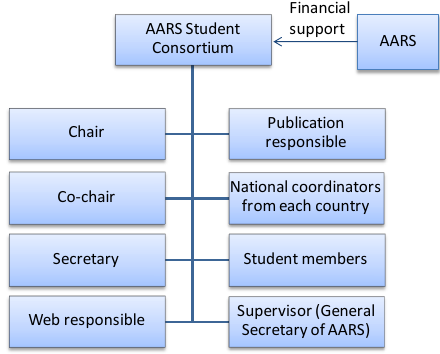
Figure 5. Proposed structure of the Student